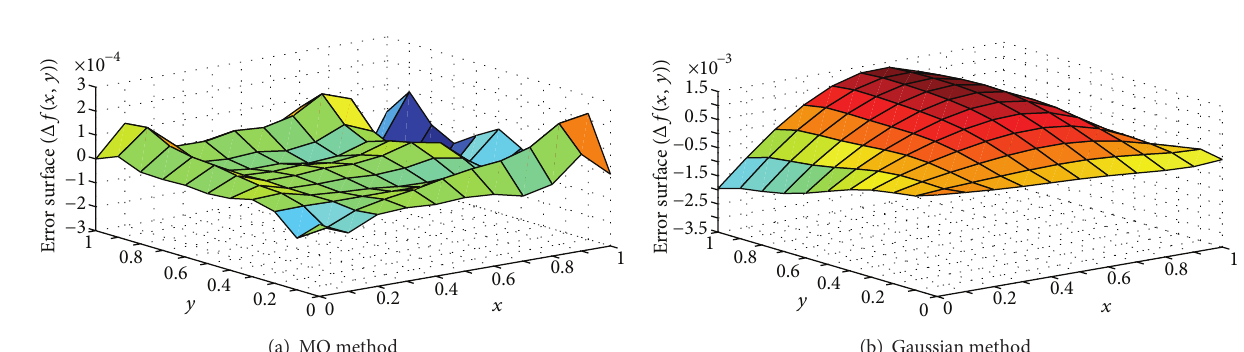
are 121 with equidistant ℎ 𝑡 = 0.1 . The RMSE, MAE, and